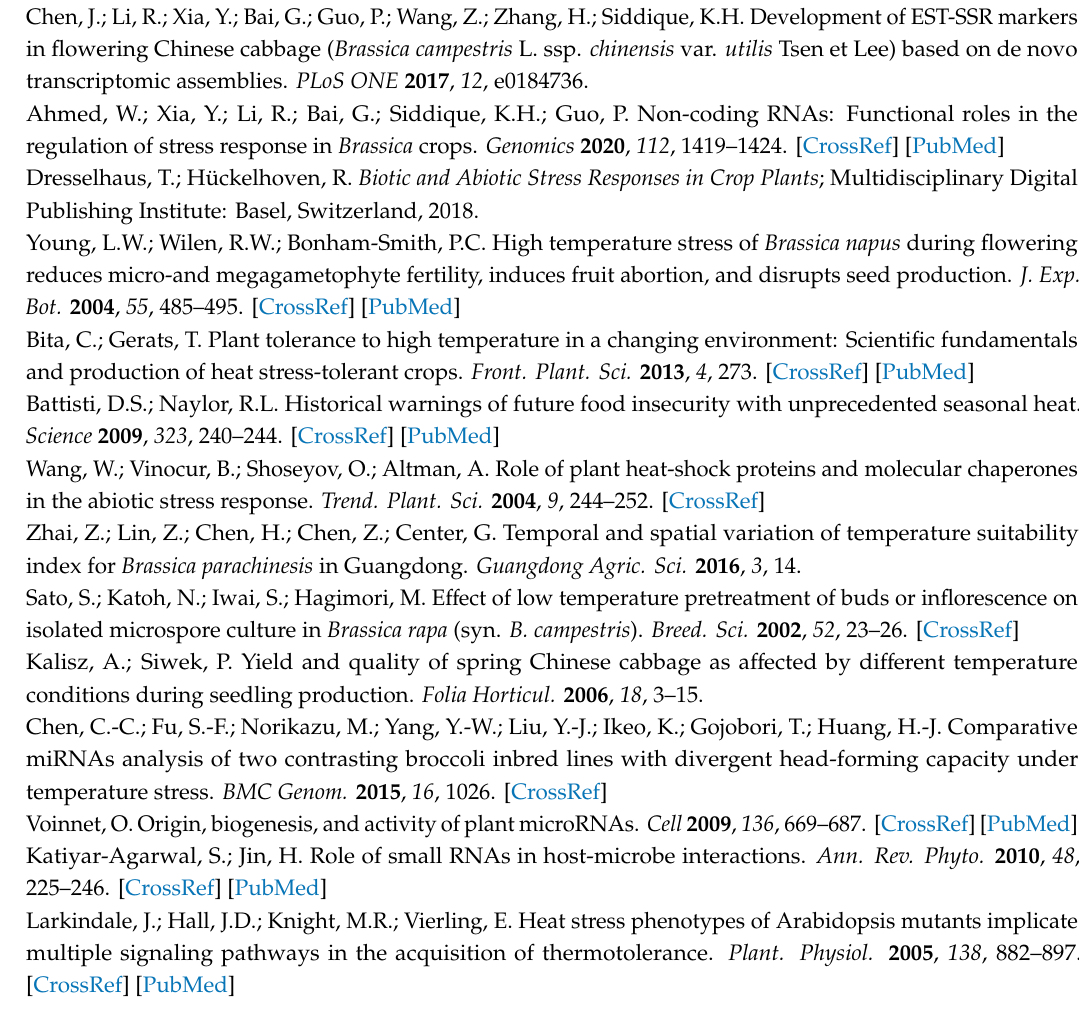
Figure S1: KEGG pathway map for MAPK signaling for heat-tolerant (HT) and heat-sensitive (HS) genotypes of flowering Chinese cabbage; Table S1: List of primers used in this study; Table S2: Analysis of small RNA sequences from the libraries of HT and HS flowering Chinese cabbage; Table S3: The length distribution and percentage of detected reads from heat-responsive total small RNAs of the flowering Chinese cabbage HT and HS genotype by sequencing; Table S4: Expression profiles of heat-responsive conserved miRNAs in HT and HS genotypes of flowering Chinese cabbage at 6 h and 12 h; Table S5: Novel miRNAs identified from HT and HS flowering Chinese cabbage genotypes under heat stress; Table S6: Di ff erentially expressed heat-responsive known miRNAs in flowering Chinese cabbage HT and HS genotypes at 6 h and 12 h; Table S7. Di ff erentially expressed heat-responsive novel miRNAs in flowering Chinese cabbage HT and HS genotypes at 6 h and 12 h; Table S8: Potential targets of di ff erentially expressed miRNAs between HT and HS Flowering Chinese cabbage under heat stress; Table S9; Gene Ontology (GO) annotation of target genes of heat stress-responsive microRNA in the HT and HS libraries of flowering Chinese cabbage; Table S10; KEGG classification of target genes of heat stress-responsive microRNAs in the HT and HS libraries of flowering Chinese